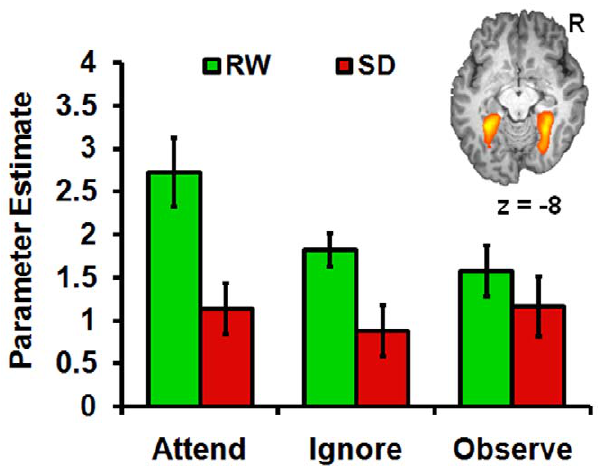
Figure 5. Effects of sleep deprivation and attention on parahippocampal place area (PPA) activation. In the rested (RW) state, attention to houses (AH) resulted in significantly greater PPA activation compared to ignoring (IH) or observing (OH) houses. However, this attention biasing was lost during SD.